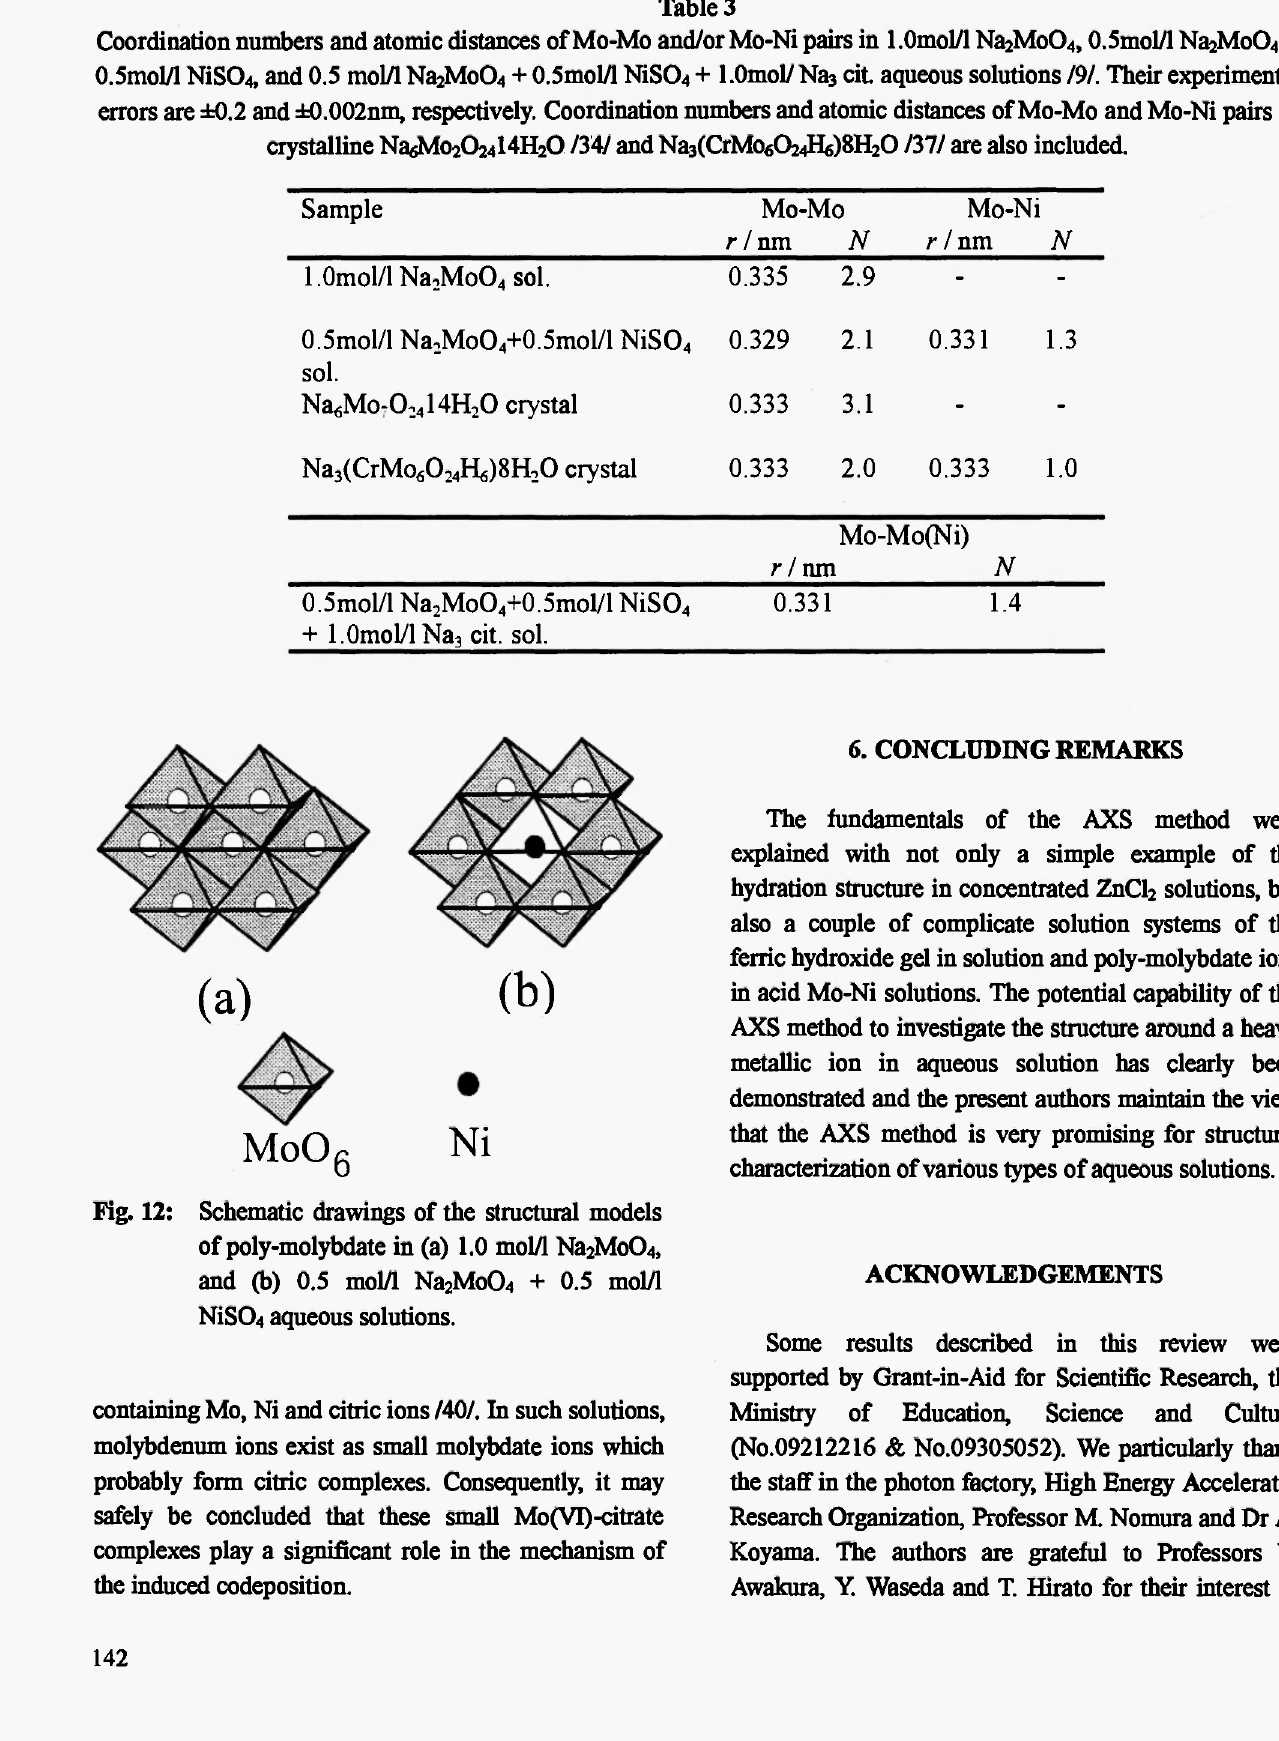
Coordination numbers and atomic distances of Mo-Mo and/or Mo-Ni pairs in 1.0mol/l Na 0.5mol/l NiS0 , and 0.5 mol/1 Na 4 errors are ±0.2 and ±0.002nm, respectively.